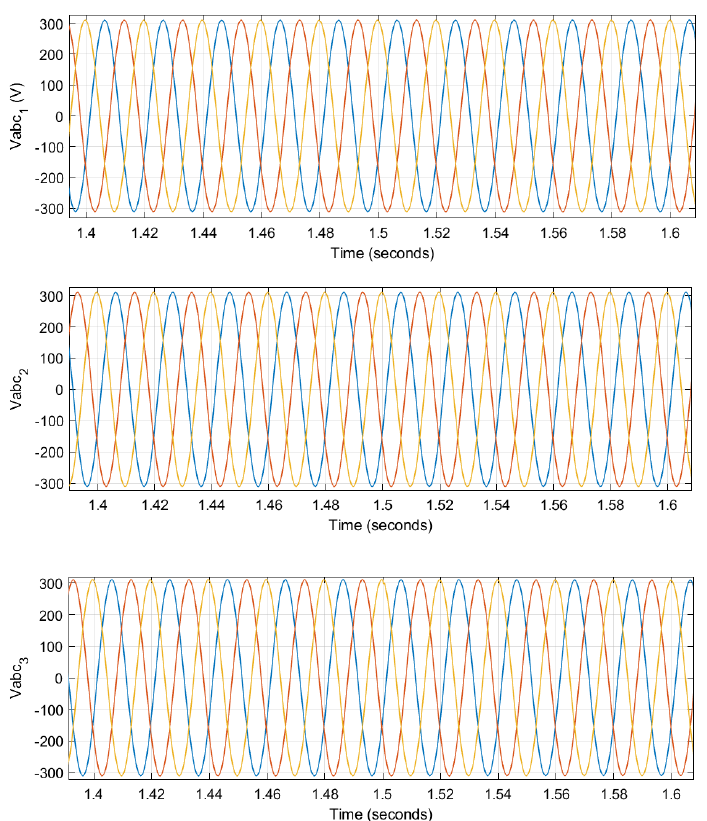
Figure 9. Output voltage reference of the droop controller with proposed virtual impedance.